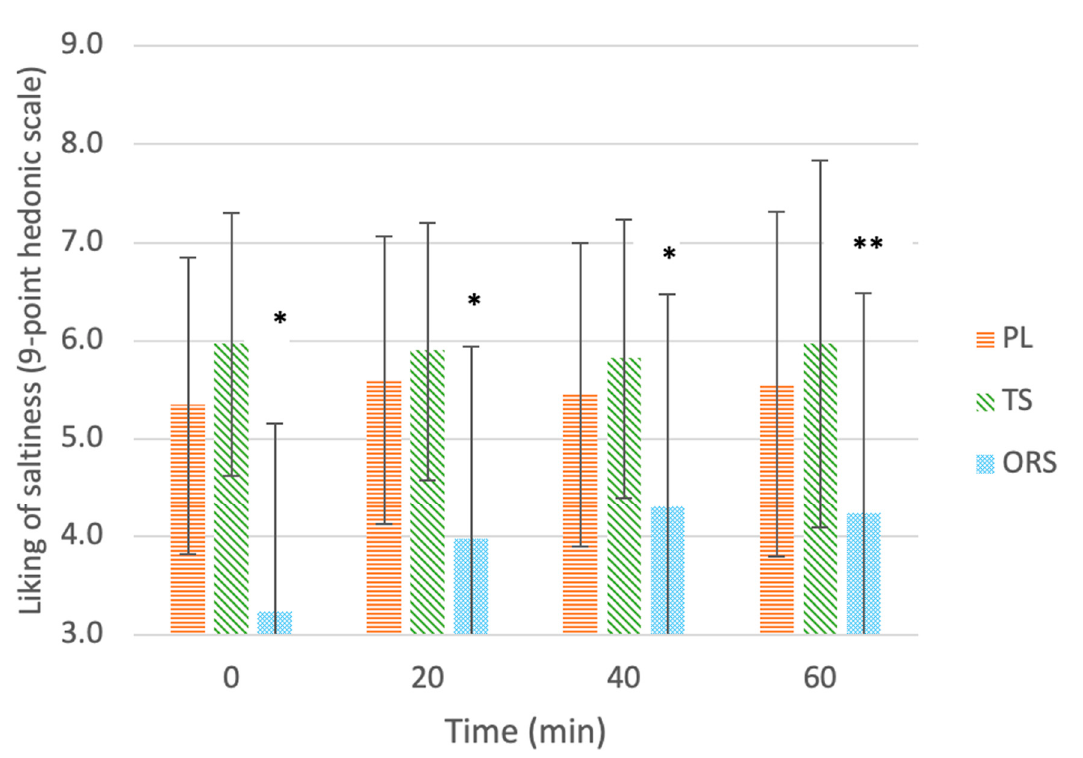
Figure 2. Liking of saltiness of drinks: ORS—oral rehydration solution, PL—placebo, TS—traditional sports drink, on a 9-point hedonic scale throughout 60 min of exercise. Values are mean ± SD. * Significant effect of the treatment vs. the placebo ( p < 0.05). ** Significant delta change in ratings compared to 0 min before exercise ( p < 0.05).